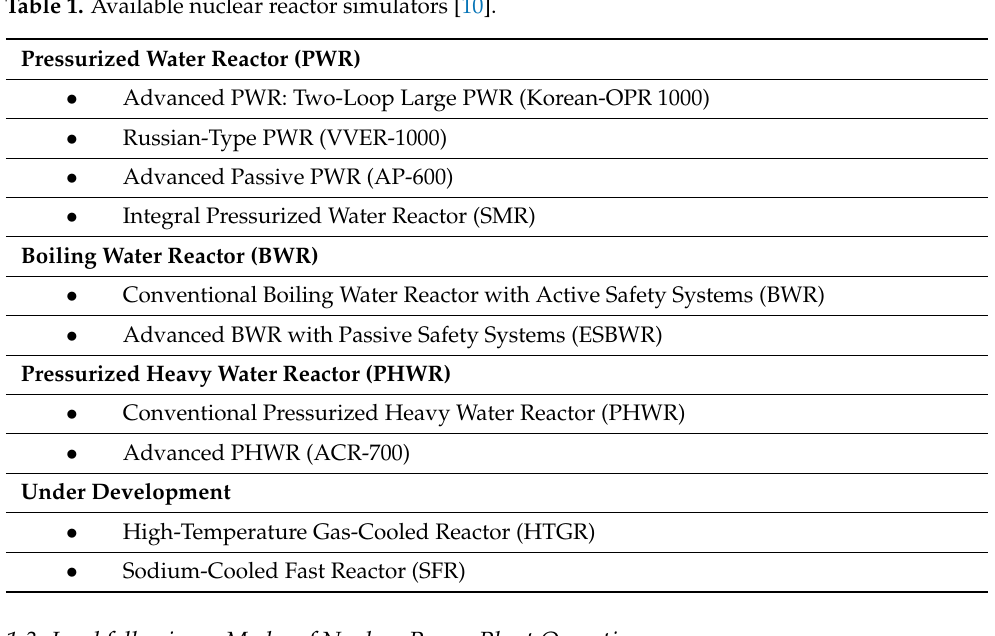
Table 1. Available nuclear reactor simulators [10].